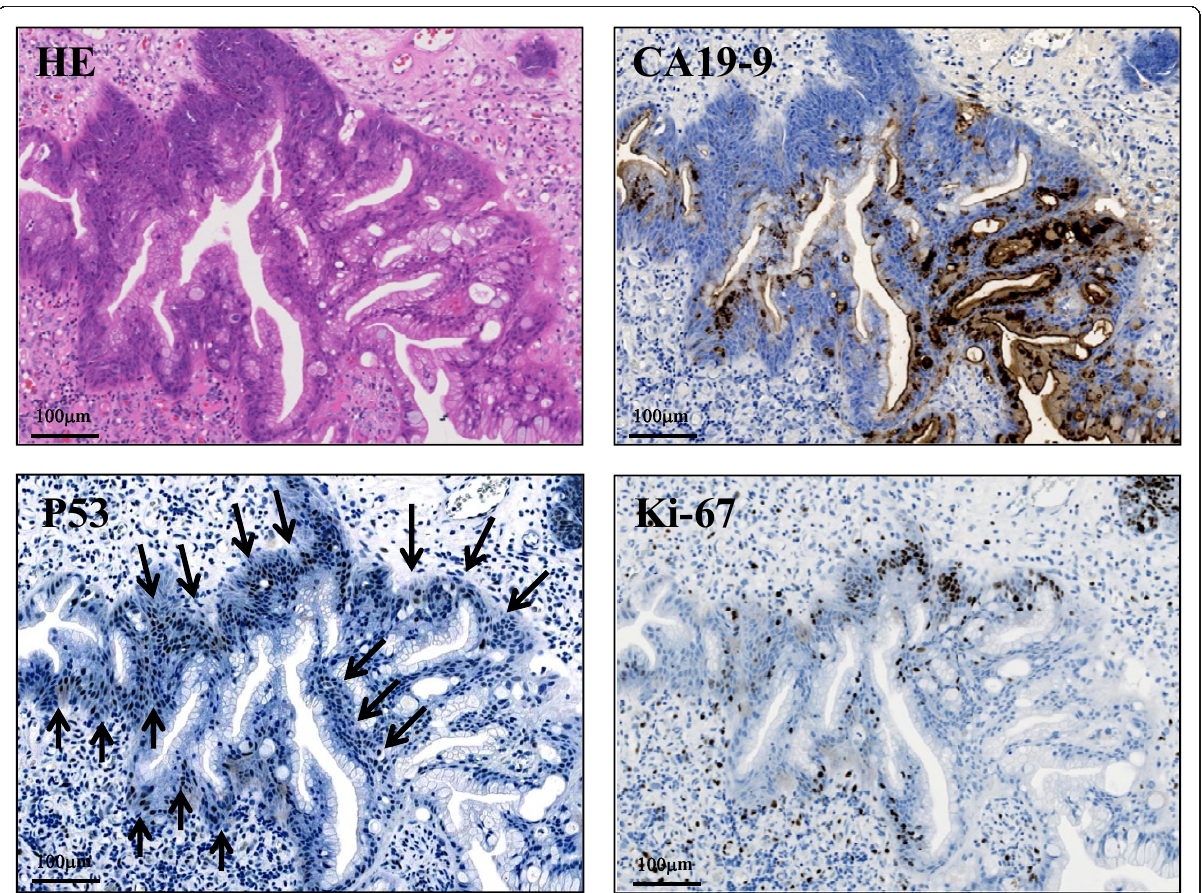
Figure 3 Microscopic examination of the adenocarcinoma arising in polyp by hematoxylin-eosin (H & E) and immunohistochemical stainings . (H & E) Small adenocarcinoma areas in the hyperplastic polyp show irregular and fused tubular structures, associated with surface erosion, granulation, hemorrhage, and inflammatory infiltrate. These structurally atypical epithelial cells contain mildly to focal moderately enlarged nuclei and occasionally prominent nucleoli with loss of cellular polarity. (CA19-9) These atypical glands are immunohistochemically positive for CA19-9, associated with strong expression especially in the secreted mucin. The CA19-9-positive staining displays not only a cytoplasmic but also an apical pattern. (p53) Distinct nuclear staining for p53 is occasionally conforming to these atypical cells (arrows). (Ki-67) Moreover, Ki-67 (MIB-1) labeling index is high (more than 5% compared to hyperplastic polyps), conforming to the small adenocarcinoma